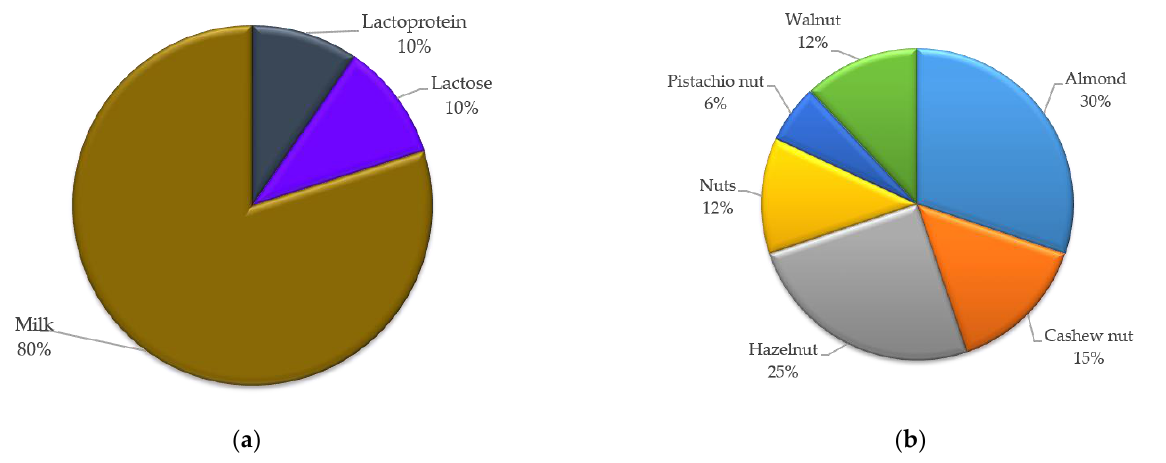
Figure 5. Percentage of notifications related to undeclared milk and products thereof as well as nuts that specified the concrete compounds present in food products: ( a ) percentage of notifications that detailed milk-related allergens; ( b ) percentage of notifications that detailed nut-related allergens.